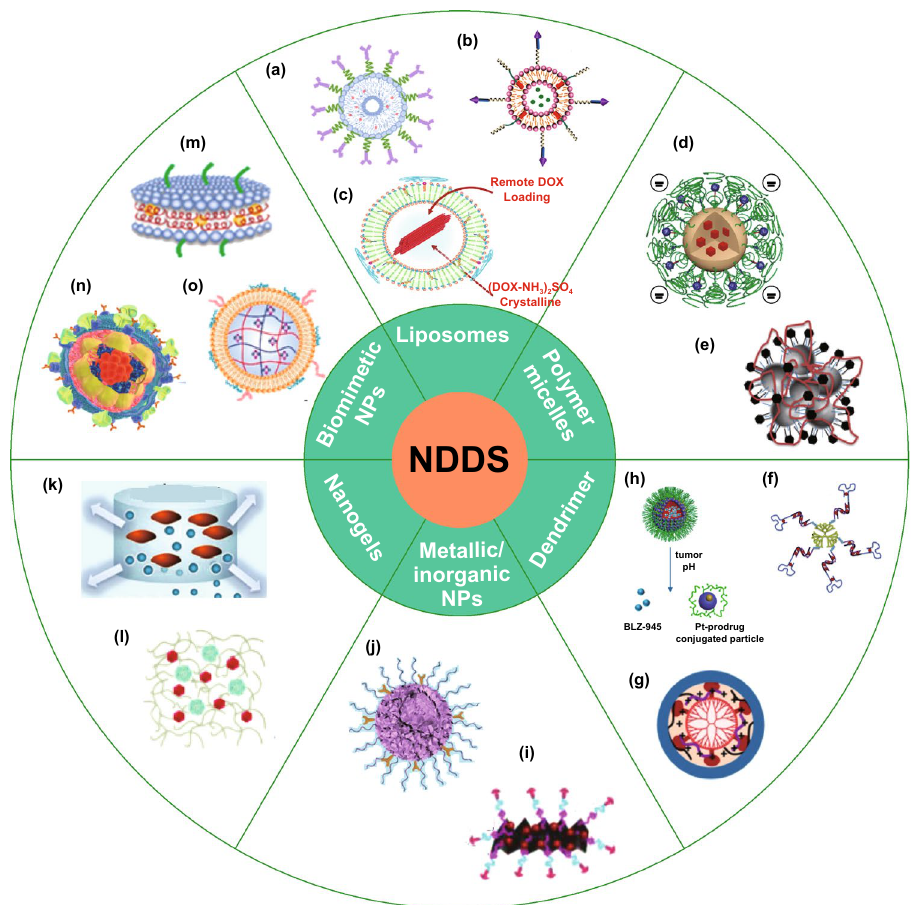
Fig. 2 Summary of NDDS for “co-encapsulation” approach in chemoimmunotherapy. Liposomes, reproduced with permission from Ref. a [104], Copyright 2018 Springer; b [105], Copyright 2019 American Chemical Society; c [106], Copyright 2018 American Chemical Society. Polymer micelles, reproduced with permission from ref d [107], Copyright 2020 John Wiley and Sons; e [108], Copyright 2015 John Wiley and Sons. Dendrimer, reproduced with permission from Ref. f [109], Copyright 2011 Elsevier; g [110], Copyright 2019 lvyspring International Pub- lisher; h [111], Copyright 2017 American Chemical Society. Inorganic NPs and Metallic NPS, reproduced with permission from Ref. i [112], Copyright 2017 American Chemical Society; j [113], Copyright 2019 John Wiley and Sons. Nanogels, reproduced with permission from Ref.